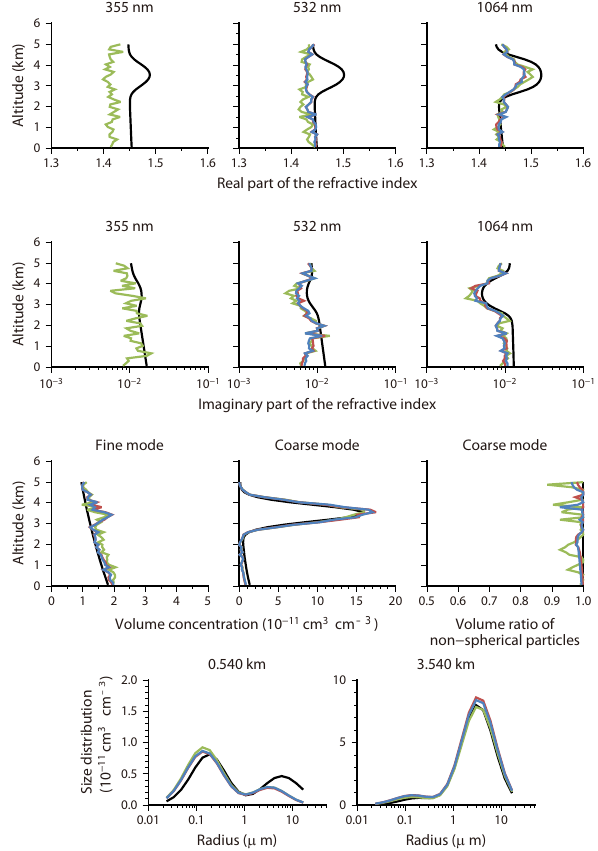
Figure 10. Figure 8 but showing the retrieval results from the sim- ulated data with random errors for the transported dust.